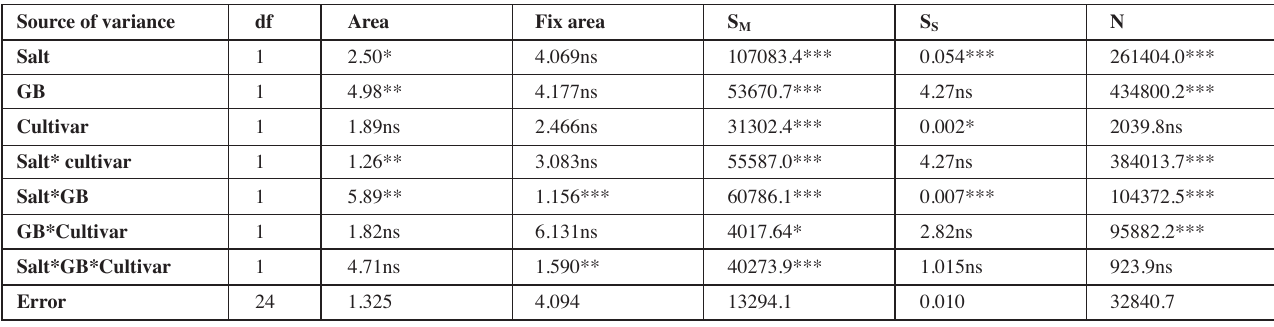
Tab. 2: Mean squares from analysis of variance of data for area, fix area, Sm, Ss and N in leaves of two cultivars of canola ( Brassica napus L.) treated with or without foliar spray of GB to salt stressed and non stressed condition.